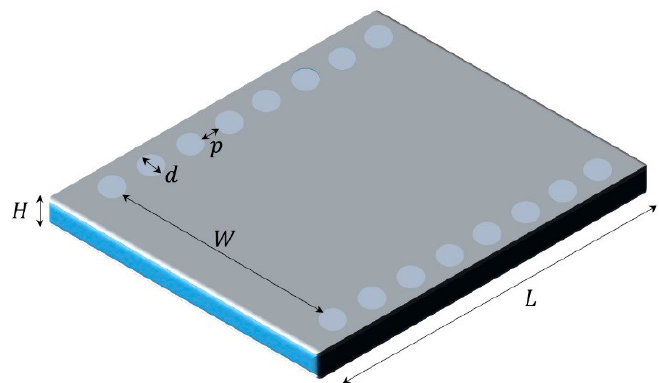
Figure 1. Schematic showing diameter and pitch of substrate-integrated-waveguide (SIW) metallic vias.